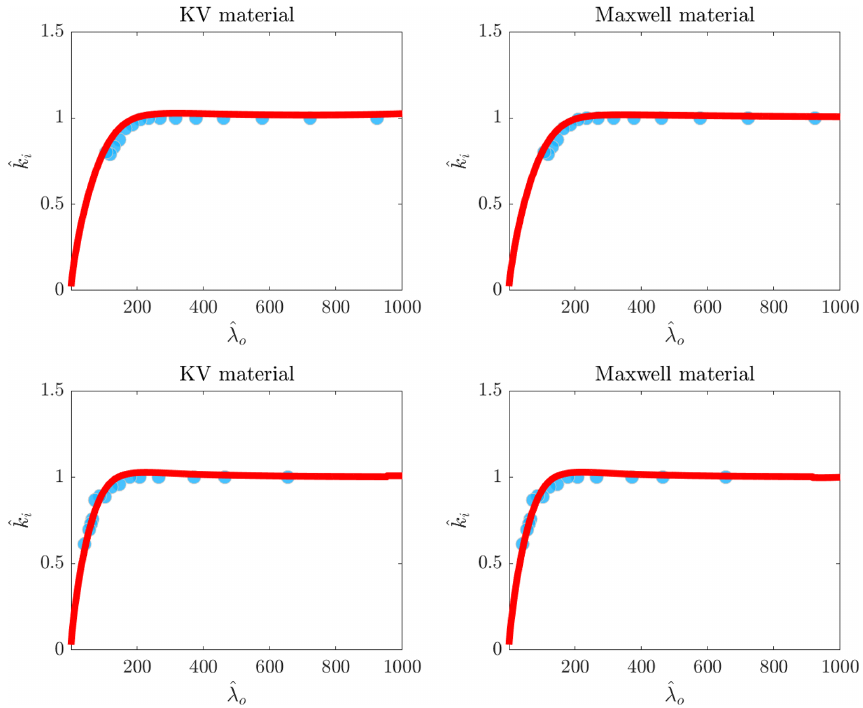
Figure 10. Comparison between ˆ k i vs. ˆ λ o curves predicted by wet beam models and the data measured by Voermans et al. (2021). Upper and lower rows respectively show data related to tests performed in Arctic and Antarctic. The shear modulus of ice is set to be 1GPa.